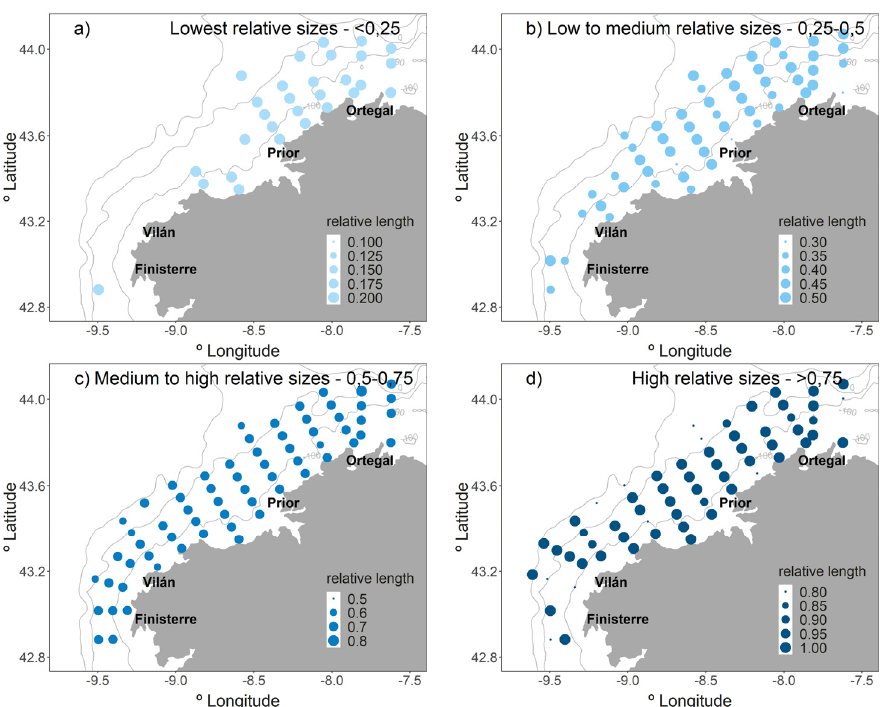
Figure 7. Larval fish community distribution by relative length: ( a ) ≤ 0.25, ( b ) [0.25–0.5], ( c ) [0.5–0.75], and ( d ) > 0.75.